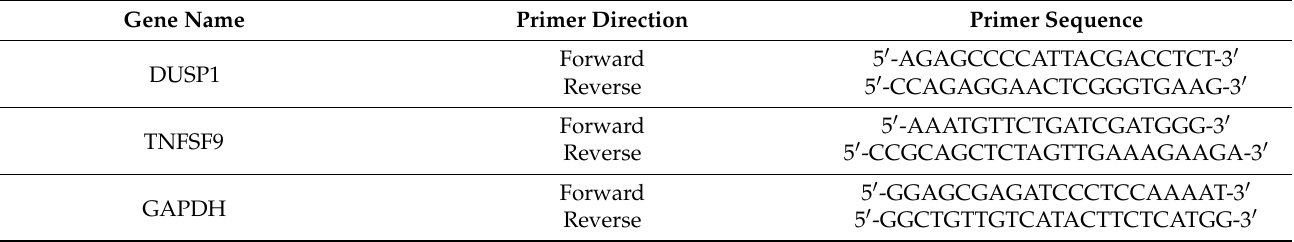
Table 4. The sequences of primers used in this